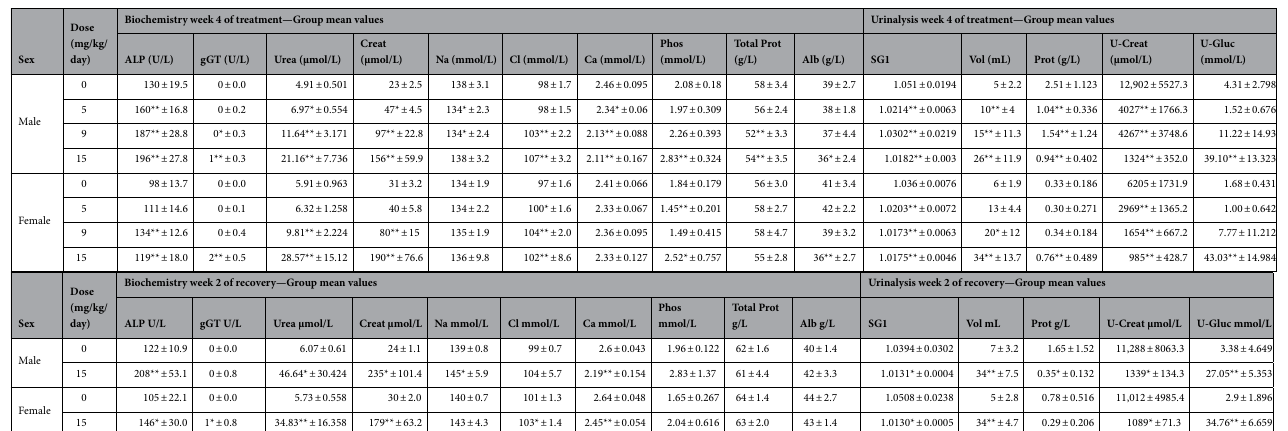
Table 3. Major changes in biochemical and urine parameters (group mean values ± standard deviation) in male and female rats treated intravenously for 4 weeks, followed by a 2-week recovery period with 0 (vehicle = 0.9% saline solution), 5, 9 and 15 mg/kg/day of SET-M33 peptide. ALP alkaline phosphatase, gGT gamma-glutamyl-transferase, Creat Creatinine, Na sodium, Cl chloride, Ca calcium, Phos inorganic phosphorus, Total Prot total protein, Alb albumin, SG1 specific gravity, Vol volume, Prot protein, U-Creat creatinine, U-Gluc glucose. Significant differences between peptide vs. control groups were expressed at the 5% (* p < 0.05) or 1% (** p < 0.01) level. For statistical analysis the Dunnett, Shirley, Williams, Wilcoxon and t tests were